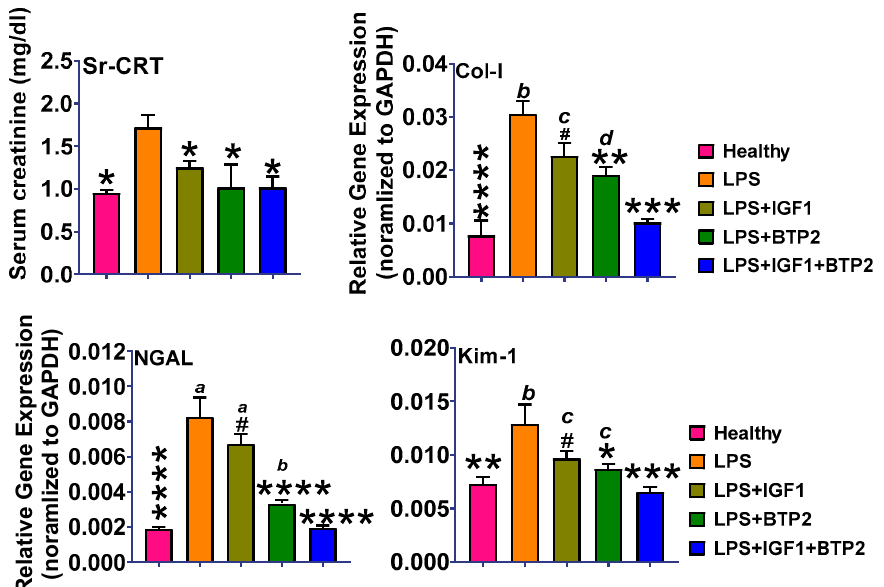
Figure 7. Favorable effects of IGF-1 and BTP-2 monotherapies and IGF-1 + BTP-2 combination therapy on LPS induced serum creatinine (Sr-CRT) and gene expression of the molecules reflecting kidney damage. See text for interpretation. Data are mean ± SEM * p < 0.05, ** p < 0.01, *** p < 0.001, **** p < 0.0001, # not significant (LPS Vs other groups) and d - p < 0.05, c - p < 0.01, b - p < 0.001, a - p < 0.0001 (LPS + IGF1 + BTP-2 Vs other groups), 1-way ANOVA followed by a Dunnett’s multiple comparisons test, ( n = 4 in each group).